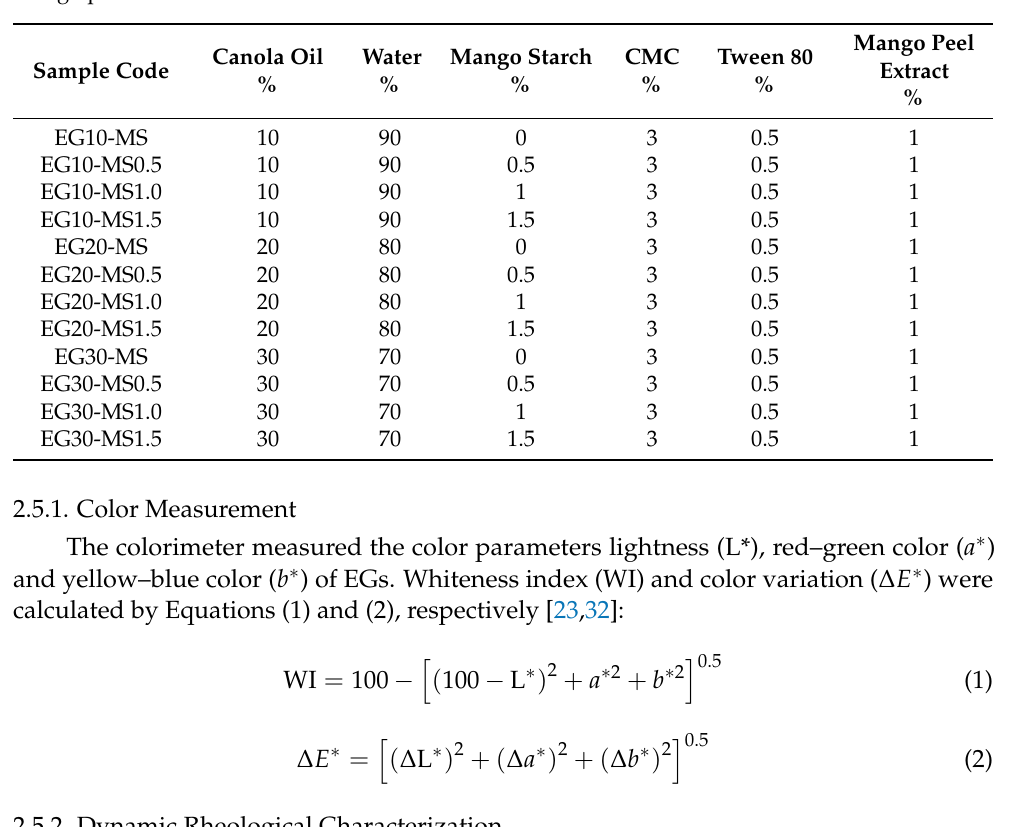
Table 1. Sample code and formulation of carboxymethylcellulose/mango starch emulsion gel with mango peel